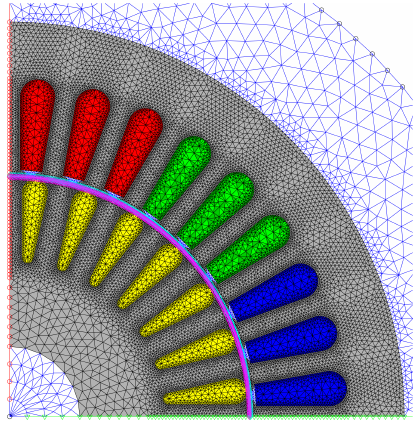
Figure 6. Mesh of the induction motor.